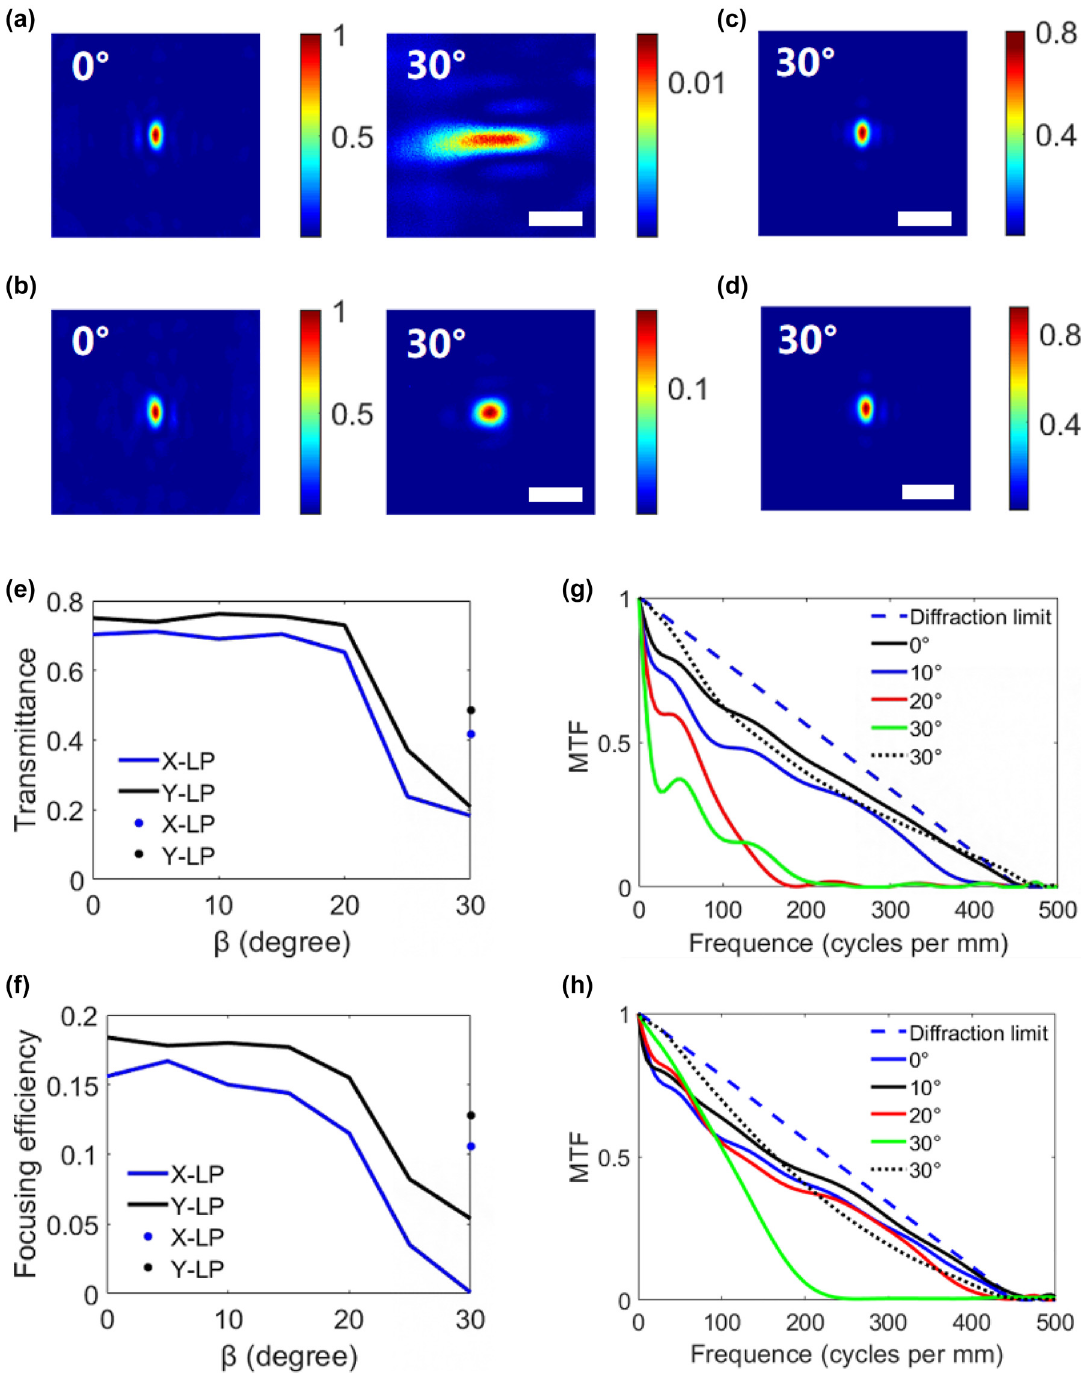
Figure 5: Experiment of polarization focusing by the metalens. (a) and (b) The focused spot of the X-LP and Y-LP components of the bifocal metalens located at (0,0), respectively. (c) and (d) The focused spot of the X-LP and Y-LP components of the bifocal metalens located at (0,30), respectively. The angle in (a)–(d) is the value of 𝛽 in the experiment. Scale bar 10 μ m. (e) and (f) Transmittance and focusing efficiency of the X/Y bifocal metalenses. The solid line and dots represent the X/Y bifocal metalens located at (0,0) and (0,30), respectively. (g) and (h) MTFs of X-LP and Y-LP components of the X/Y bifocal metalenses, where the solid and dashed lines represent the X/Y bifocal metalens located at (0,0) and (0,30), respectively, and the dashed line represents the diffraction